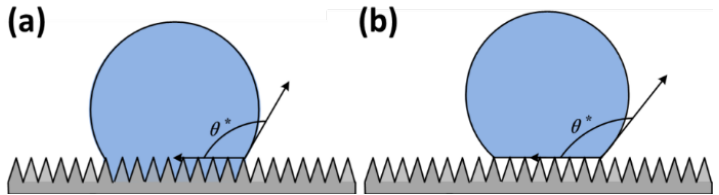
Figure 6. ( a ) Wenzel wetting model and ( b ) Cassie–Baxter wetting model.